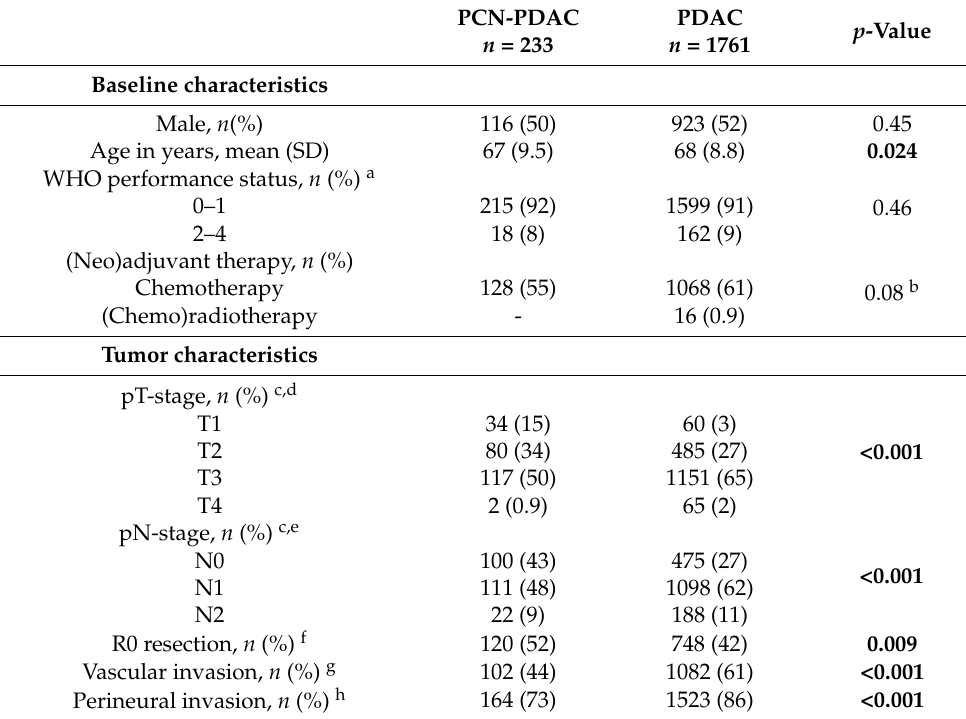
Table 1. Baseline and tumor